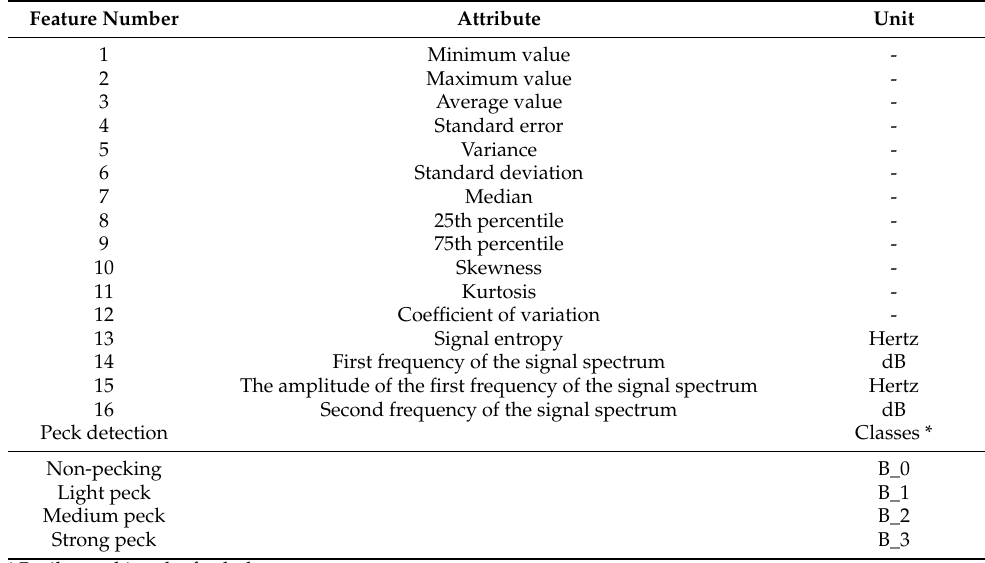
Figure 2. Schematic view of the process used in the current study.